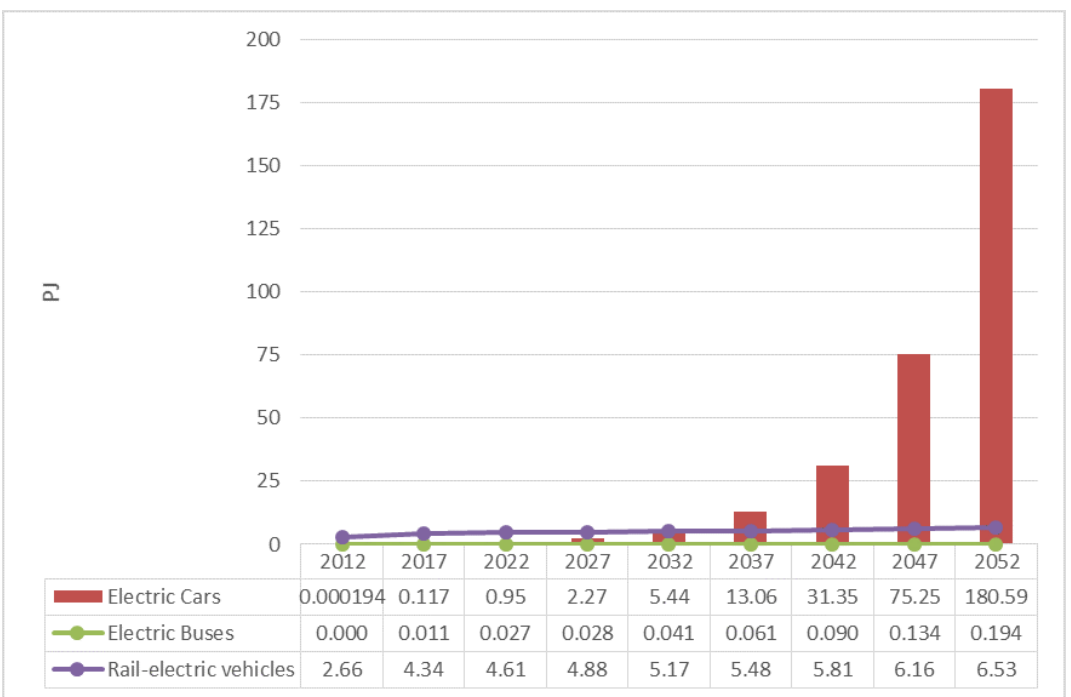
Figure 5. Electricity consumption of the transport sector by vehicle type: BASE